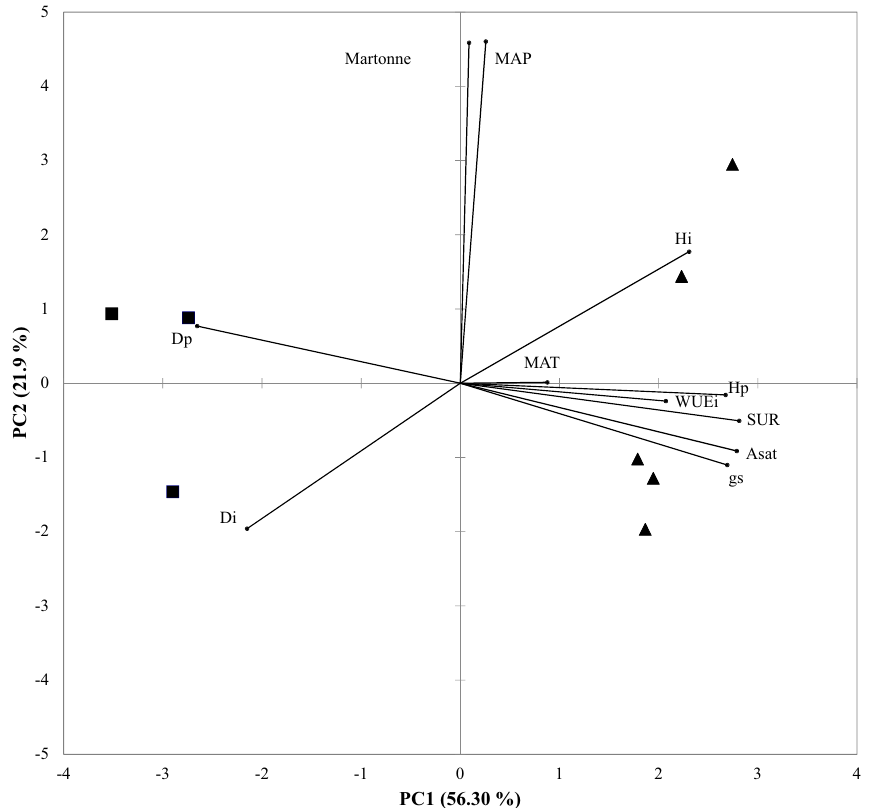
Figure 6. Principal Component Analysis among seedling performance and climate at provenance locations. Each squares and triangle represents a provenance of C . alba and Q . saponaria , respectively. In the case of C . alba , provenances HU and LI were absent due to they had no alive seedlings after the post transplanting shock. SUR survival after outplanting, Di diameter at planting, Hi height at planting, Dp diameter after outplanting, Hp height after outplanting, A sat photosynthesis after outplanting, g s stomatal conductance after outplanting, WUEi water use efficiency after outplanting, MAP mean annual precipitation, MAT mean annual